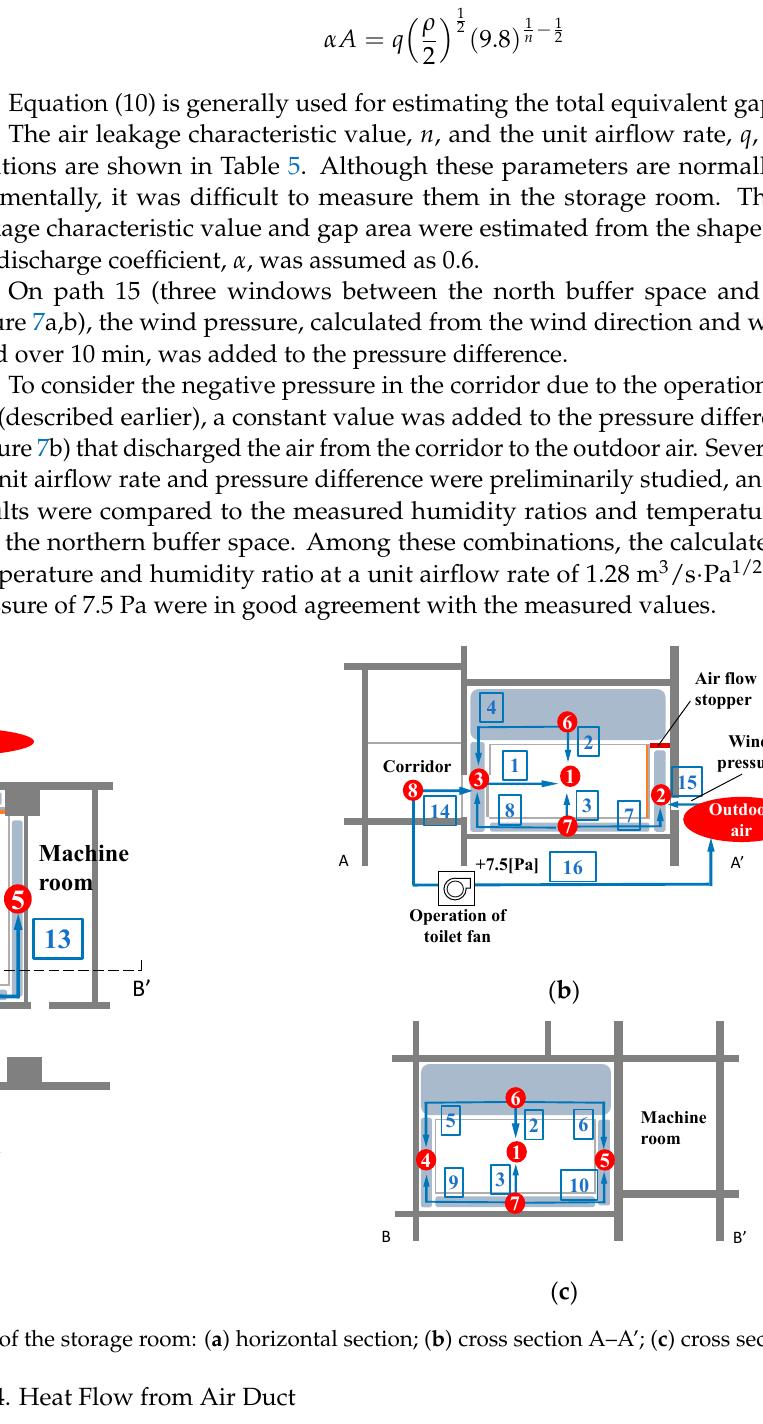
Figure 8. Schematic of the window gap. 3.4.4. Heat Flow from Air Duct For the heat flow from the duct, UA duct ( T Upper Floor − T Attic space ; W) was added to the heat balance of the attic space, assuming the heat transmission coefficient, U , as 1.25 W/ m 2 .K and the duct area, A duct , as 5.26 m 2 ( T Upper Floor and T Attic space indicate the temperature of the upper floor and that of the attic space, respectively ) . The condensation on the surface of the duct would likely occur, leading to a degradation in the insulation performance of glass wool. In this numerical model, the thermal conductivity of wet glass wool was as- sumed to be 0.07 W/m.K, which was twice as high as in dry conditions. 3.4.5. Conditions of Surrounding Areas The temperature and RH of the east and west rooms of the subject storage room, corridor, outdoor air, and upper- and lower-floor rooms (the blue circles in Figure 4a,b) were input-based on the measured data and updated at each time step of the analysis. The values of temperature and RH were assumed to change linearly during the measurement interval. The temperatures and RHs in the storage room, the attic space, the northern buffer space, the south corridor, the adjoining rooms to the east and west, and the room directly above were also measured [4]. The measurements started in February 2018, except